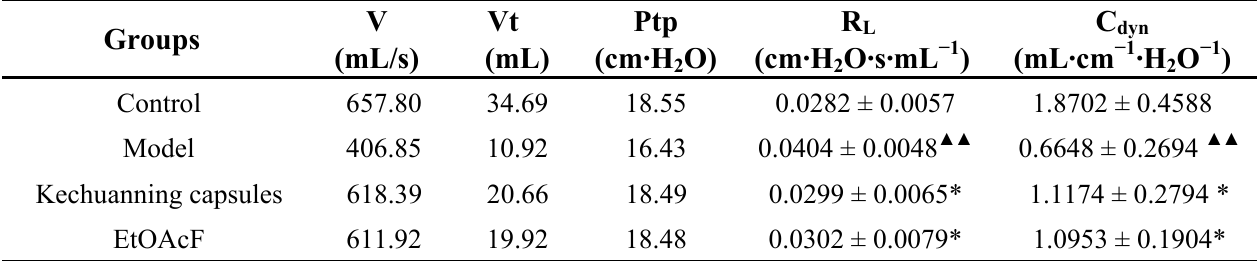
Table 1. Effect of EtOAcF on lung resistance and dynamic lung compliance challenged with cigarette inhalation in stable phase COPD rats.